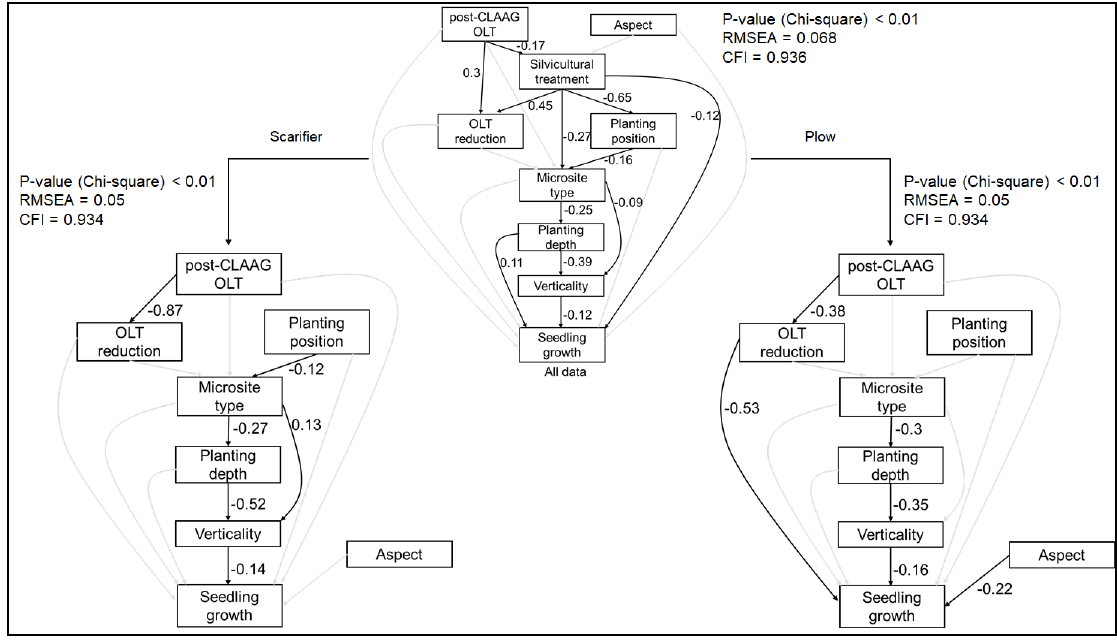
Figure 6. Path analysis summarizing the direct and indirect correlations influencing seedling growth, as expressed by their relative growth rate in volume index. The analysis was performed for all of the data combined and for the scarifier ( left ) and plow ( right ) separately. The variables included account for 50% of the variability. Darker arrows indicate significant correlations. The number beside each arrow is the coefficient representing the influence of each correlation. The parameters used to fit the models were the Root Mean Square Error of Approximation (RMSEA) and the Comparative Fit Index (CFI). OLT: organic layer thickness; CLAAG: careful logging around advance growth.